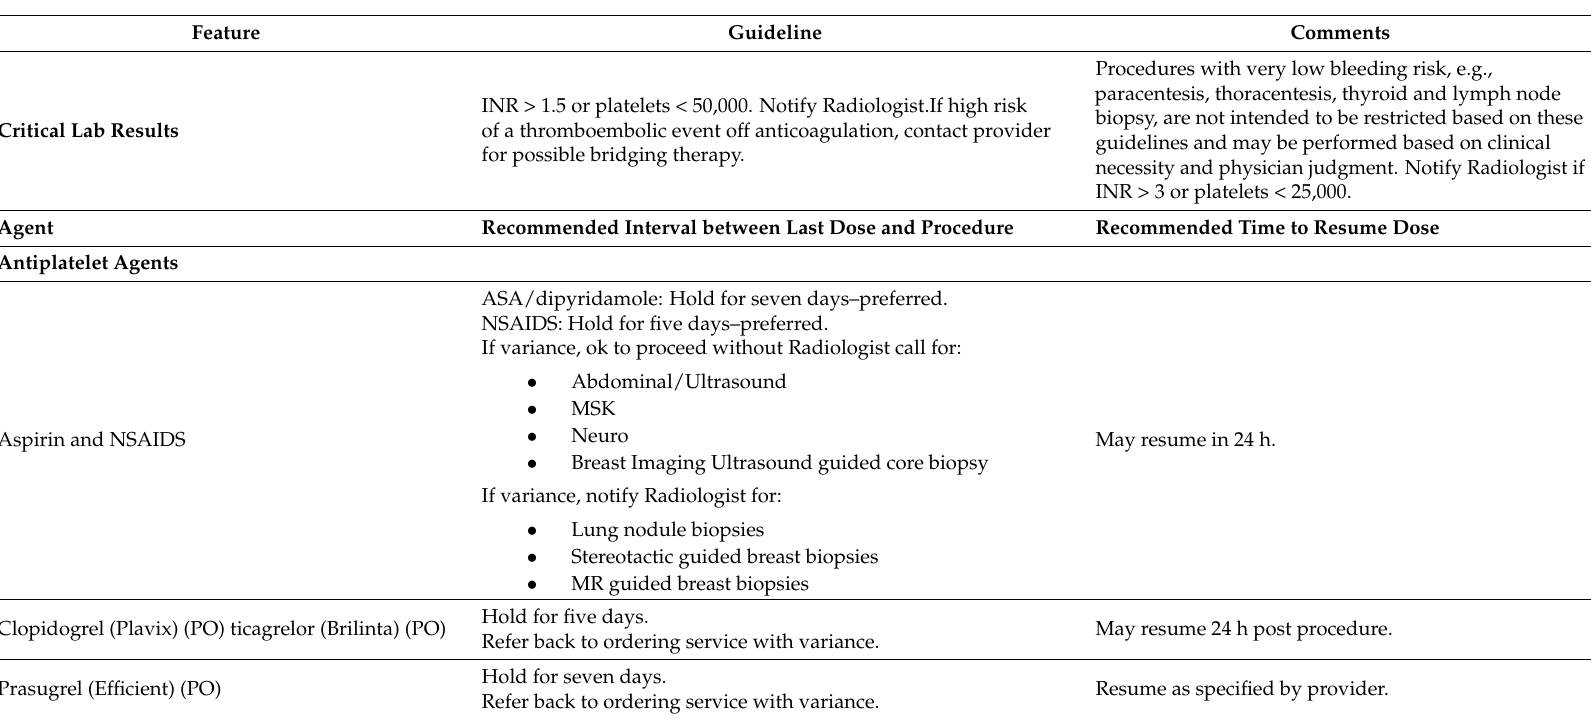
Table 3. Radiology anticoagulation guidelines a